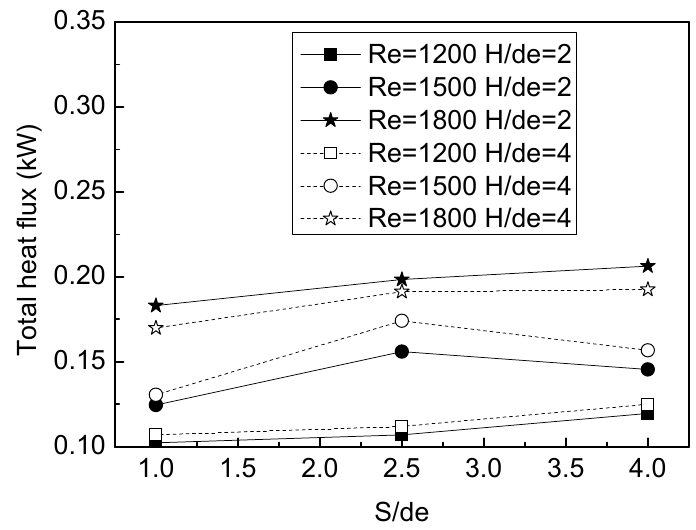
Figure 4. Total heat flux variations of LPG premixed flame array.